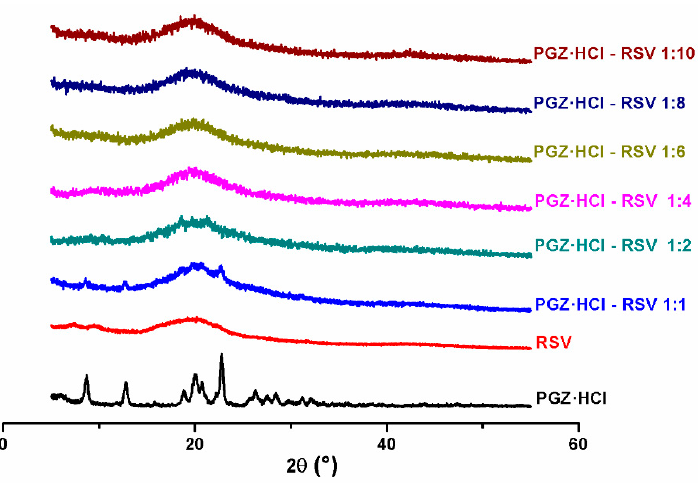
Figure 5. XRPD diffractograms of the solid forms of PGZ·HCl-RSV at different stoichiometric ratios